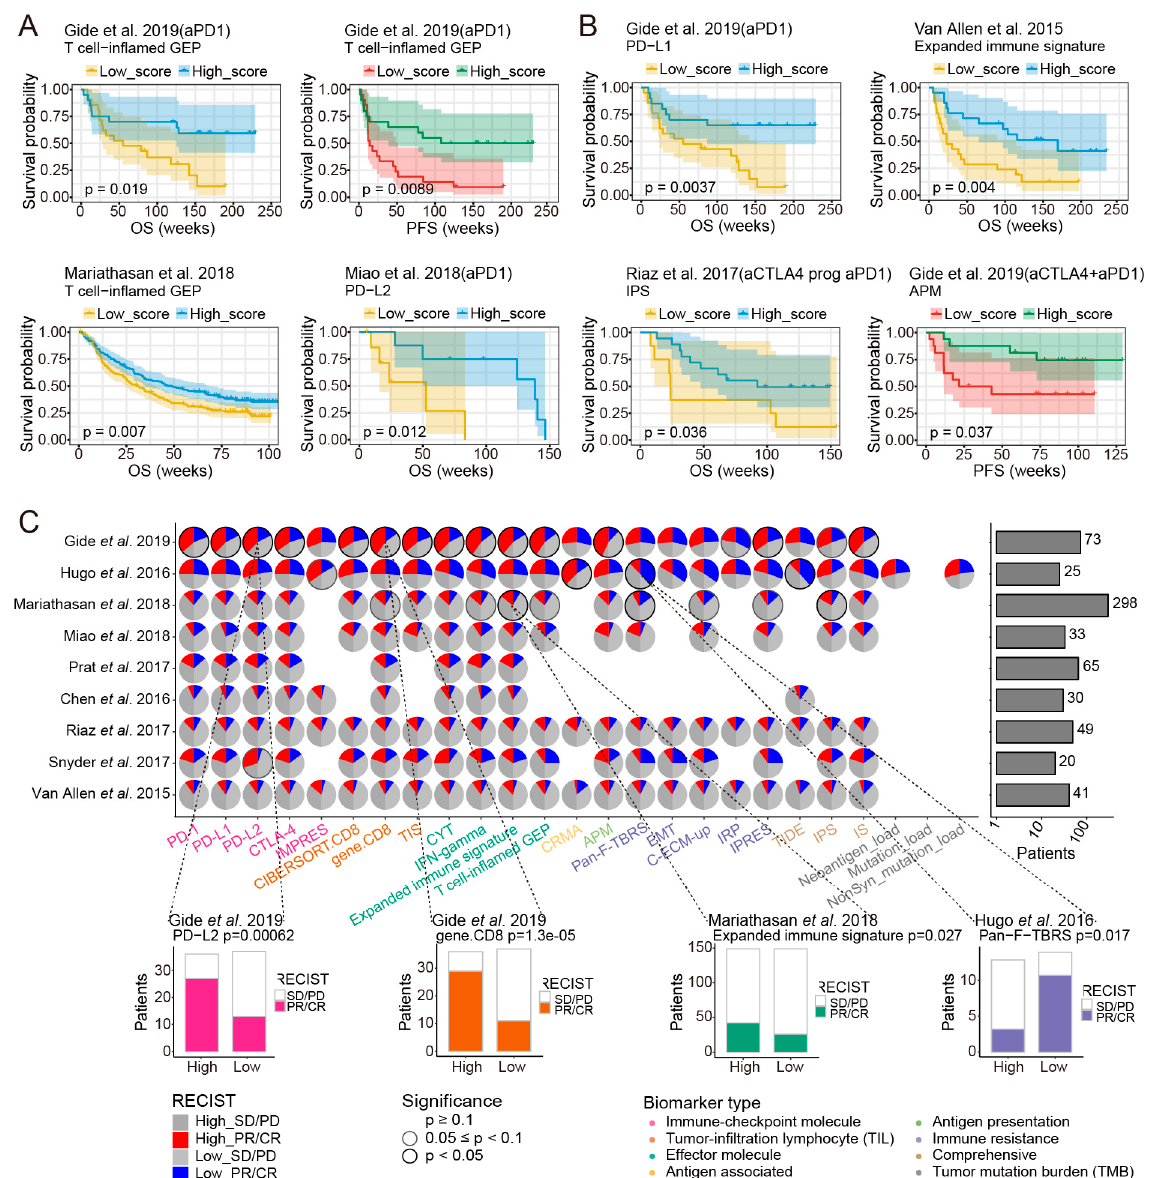
Figure 6. The impact of ICB response biomarkers on clinical efficacy of ICB therapy. Kaplan–Meier survival curves showing OS or PFS for patients with high versus low scores of ( A ) T cell-inflamed GEP in melanoma, T cell − inflamed GEP in UC and PD − L2 in ccRCC. Kaplan-Meier survival curves showing OS for patients with high versus low scores of ( B ) PD − L1 under anti-PD-1 therapy, Expanded immune signature under anti-CTLA-4 therapy and IPS under “anti-CTLA-4 prog anti-PD-1” therapy. Kaplan–Meier survival curves showing PFS for patients with high versus low scores of APM under the combination anti-PD-1 and anti-CTLA-4 therapy. ( C ) Top: the pies on the left panel showing the significance of association for each response biomarker in each overall benchmark dataset and the barplots on the right panel showing the numbers of patients in each dataset. The left half of the pie chart represented the patients with high scores of the corresponding biomarkers, red and dark gray indicated the proportion of responders and non-responders in high-score patients, respectively. The right half of the pie chart represented the patients with low scores of the corresponding biomarkers, blue and light gray indicated the proportion of responders and non-responders in patients with low-score patients, respectively. Borders with no color, gray borders and black borders represented p ≥ 0.1, 0.05 ≤ p < 0.1, p < 0.05, respectively. Different categories of biomarkers were represented by different colors. Bottom: objective response in patients with high versus low scores of PD-L2 and gene.CD8 in the Gide et al., 2019 dataset, Expanded immune signature in the Mariathasan et al., 2018 dataset and Pan − F − TBRS in the Hugo et al., 2016 dataset. Proportion of PR/CR were colored on histograms based on the categories of corresponding biomarkers, with the numbers of patients shown in each bar. Datasets with less than 20 samples were excluded from the analysis.